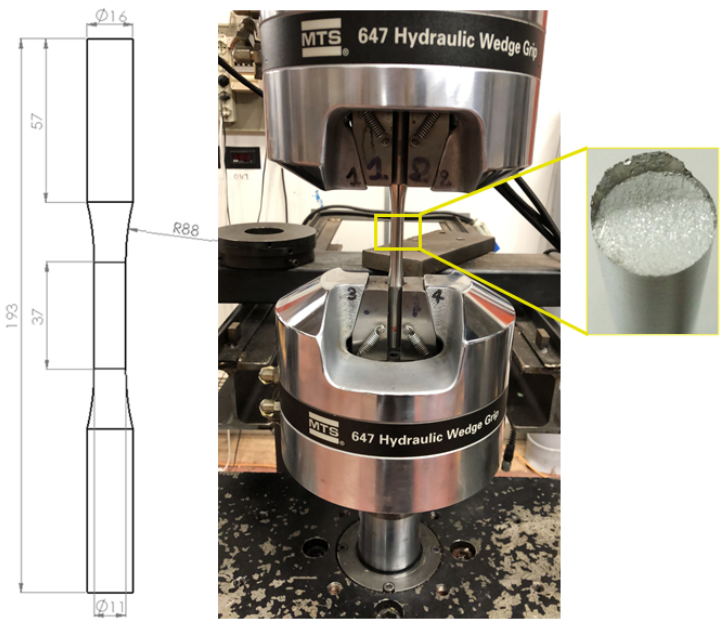
Figure 2. Fatigue sample specifications, test set-up and fracture surface (Sanguedolce et al, 2021)